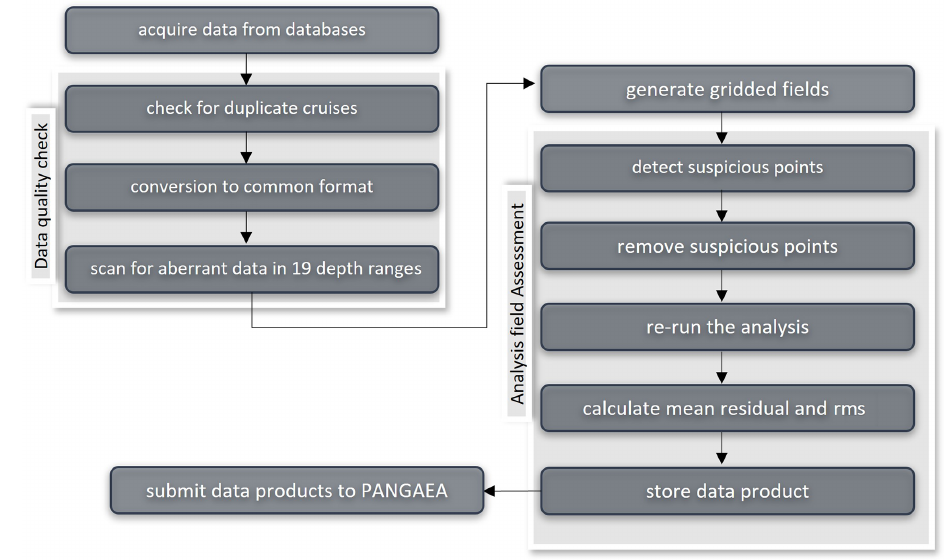
Figure 4. Flowchart describing the steps during the quality control; see text in Sects. 2.3 and 3.3 for more details.